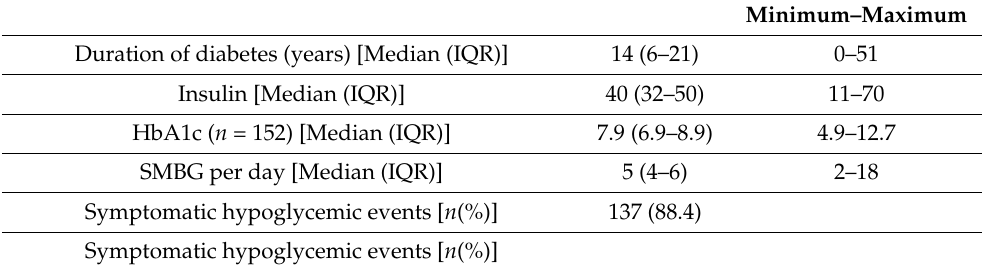
Table 3. Parameters of glycemic control at